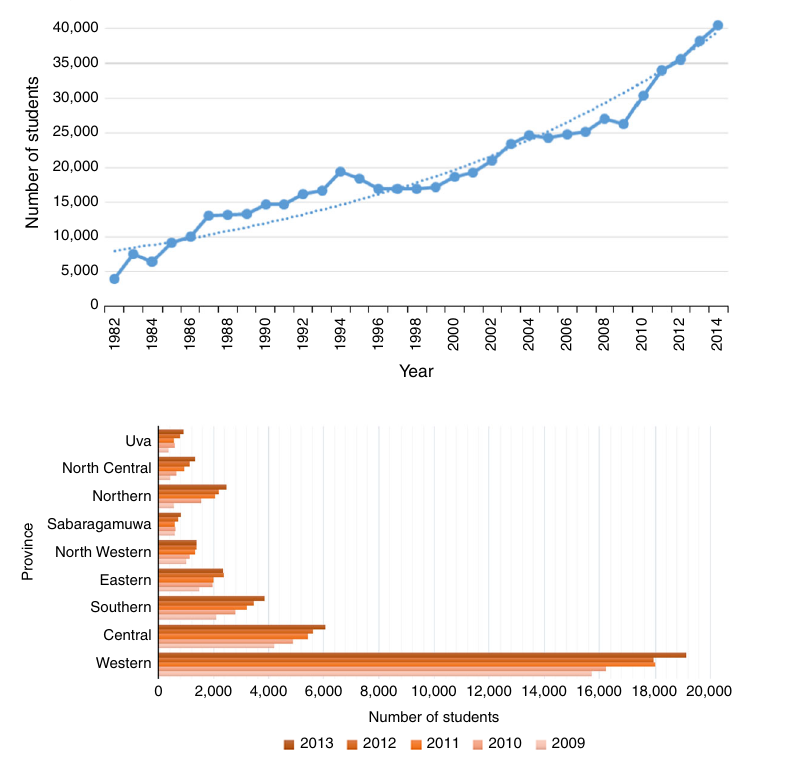
Figure 2. Student